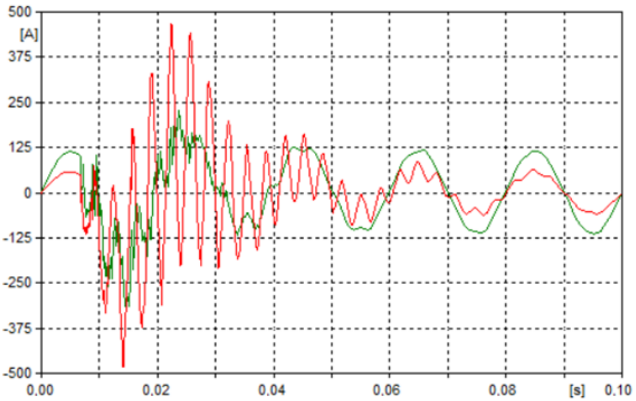
Figure 9. Current waveform of a multi-system lines for transmission line 110 kV (red waveform) and 220 kV (green waveform).